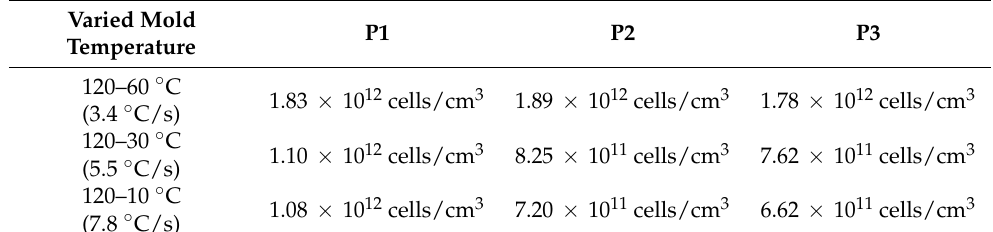
Figure 9. The effect of DMTC corresponding to different cooling rates on foaming morphology.